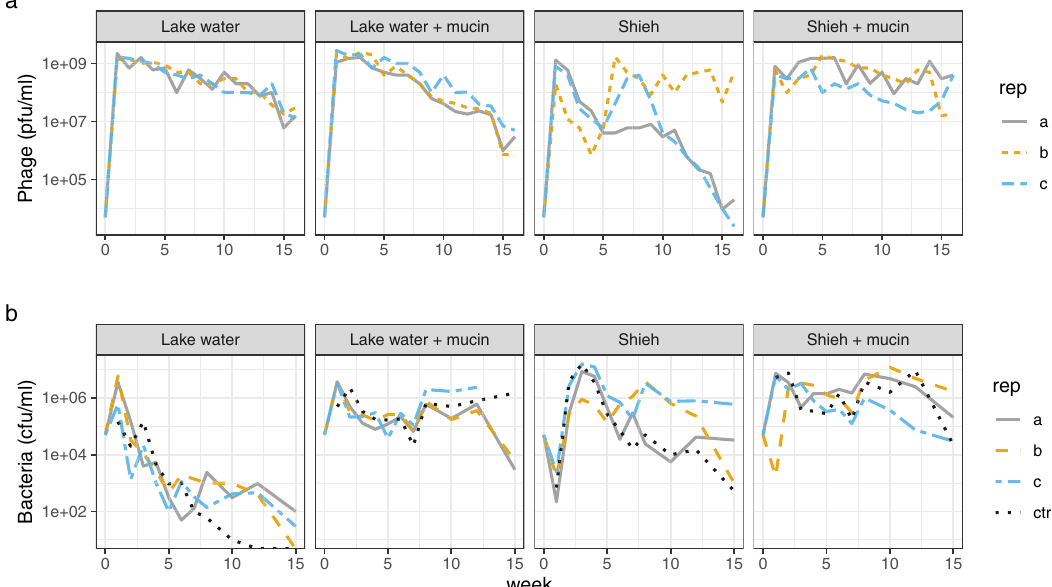
Fig. 2 Phage V156 (a) and F. columnare B245 (b) titers over the 16-week experiment in the four treatments. Each line represents one of the three replicates in each treatment. The dotted lines in ( b ) are control cultures without phage. Source data are provided as a Source Data fi